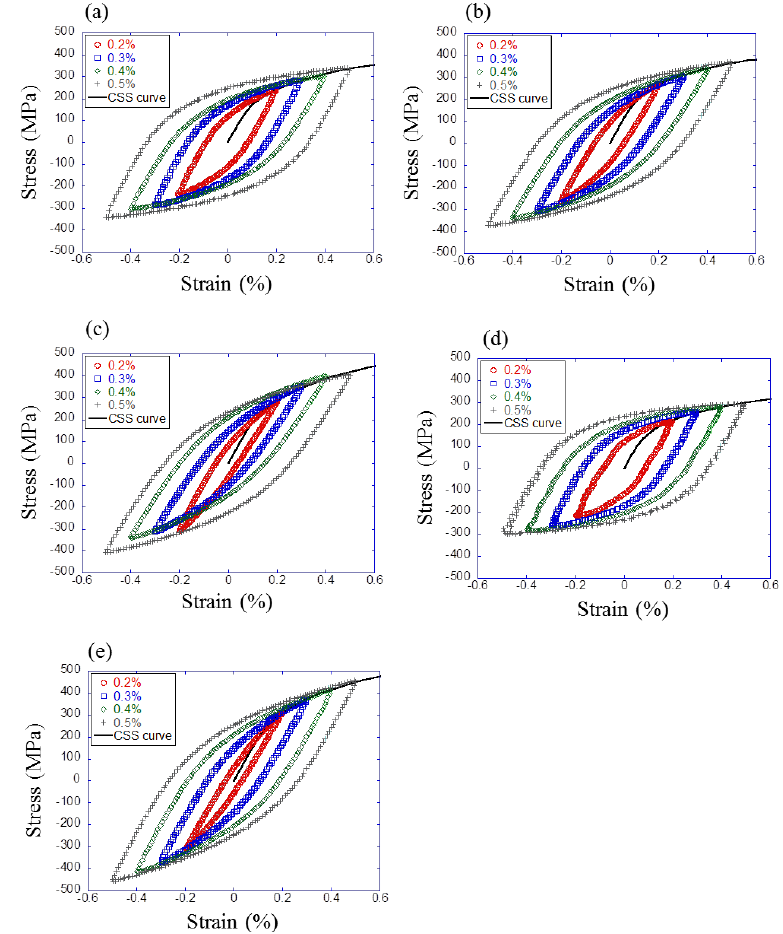
Figure 5. Experimental stress–strain hysteresis loop and cyclic stress–strain (CSS) curve for ( a ) S25C, ( b ) S35C, ( c ) S45C, ( d ) K1, and ( e ) Pearlite steels. Table 2. Material constants of Ramberg–Osgood relationship.